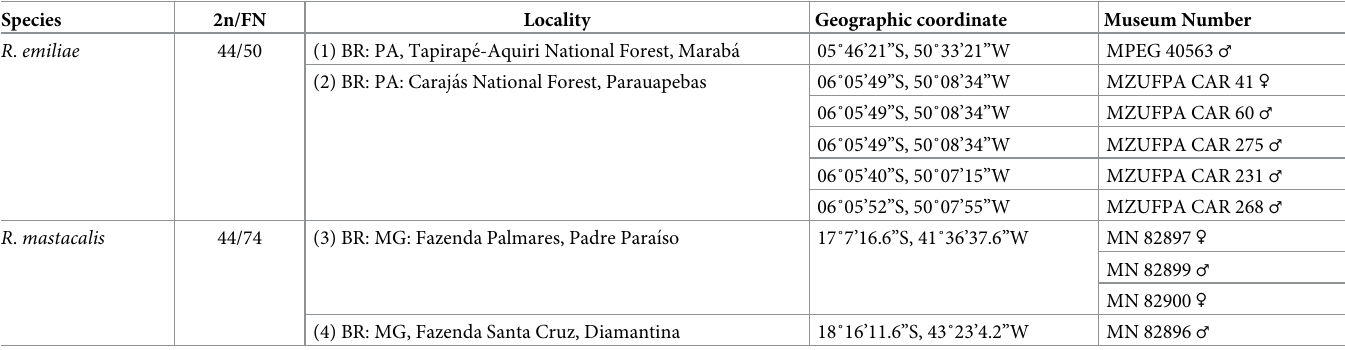
Table 2. Samples and collection localities of R . emiliae and R . mastacalis